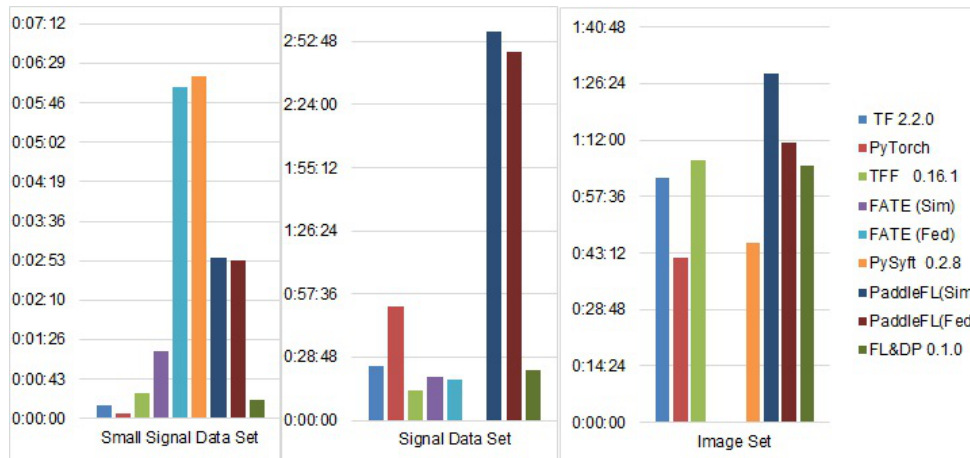
Figure 10. Training time of the FL